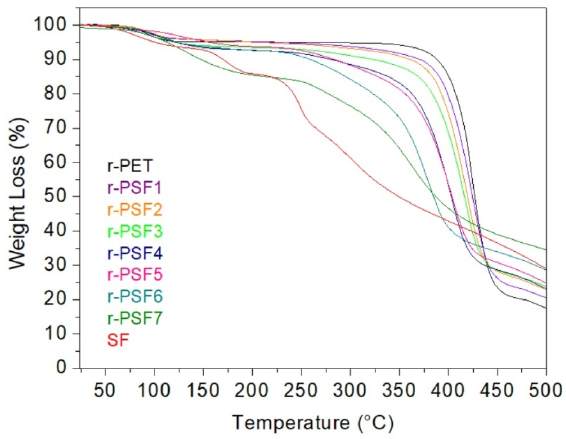
Figure 6. Thermogravimetric analysis of investigated membranes at temperatures between 30 and 500 °C.